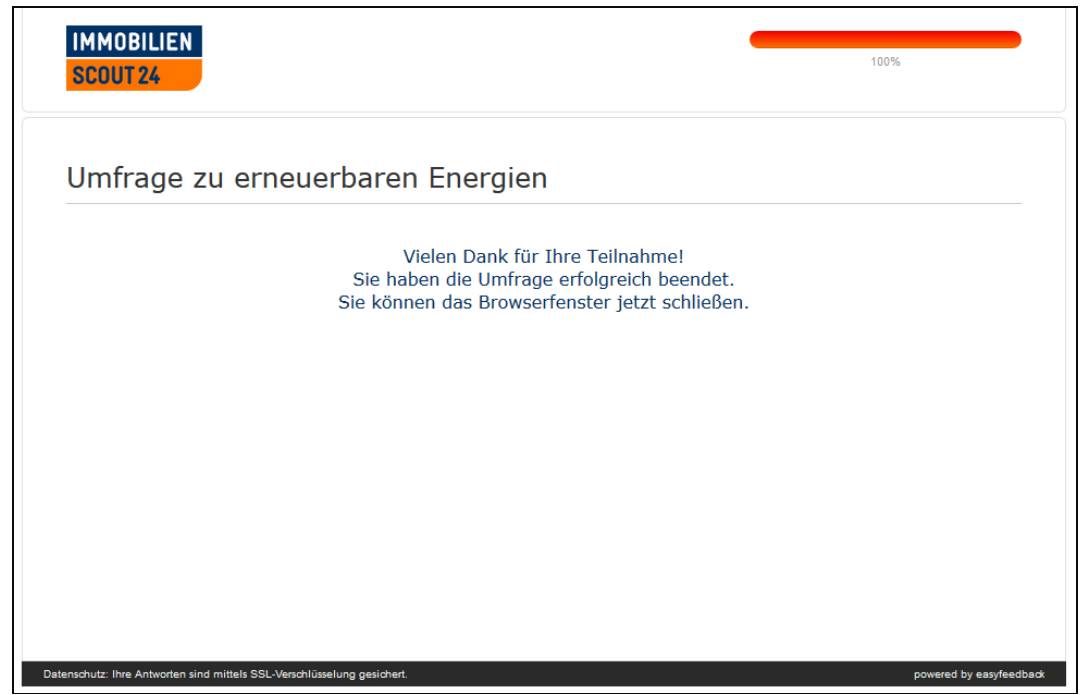
Figure A19. Screenshot of Questionnaire Page 18.